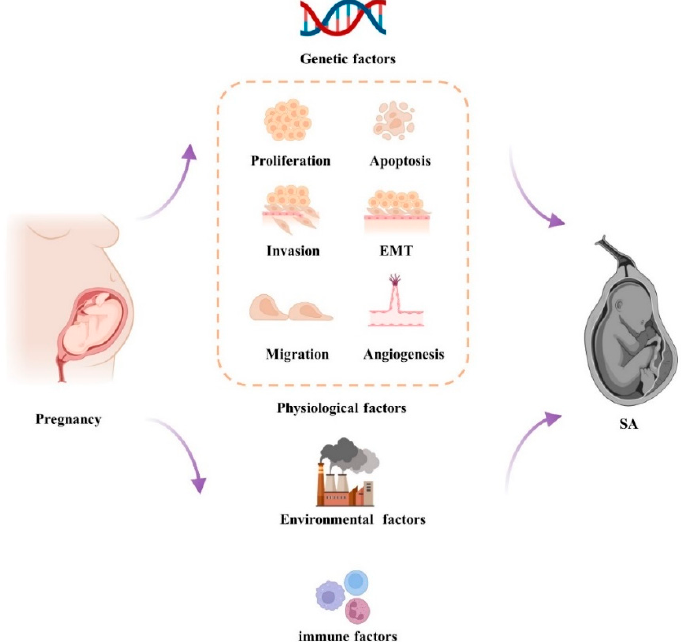
Figure 1. Etiology of SA. It is currently known that the factors affecting SA are genetic factors, physiological factors, environmental factors, and immune factors. Among them, genetic factors are the most crucial etiology of SA. EMT, epithelial-mesenchymal